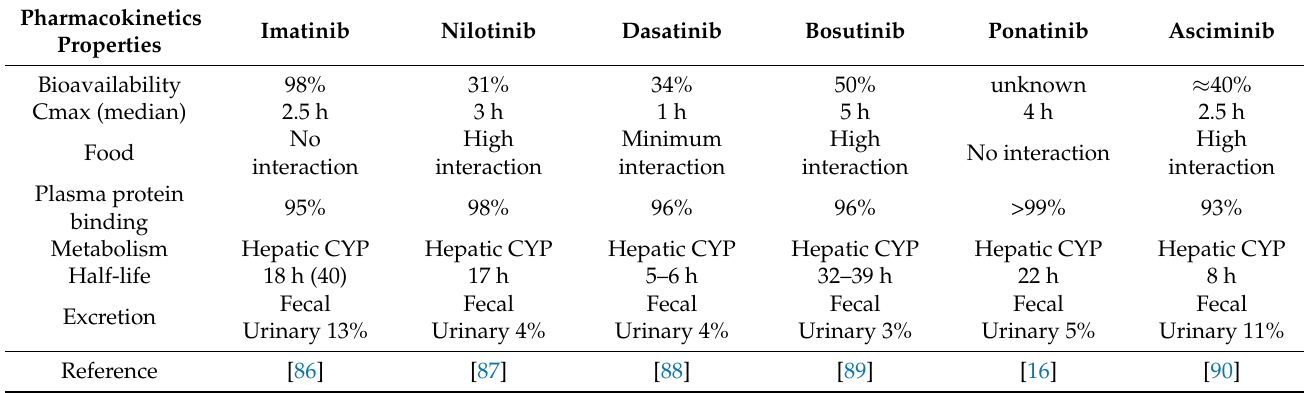
Table 5. ADME pharmacokinetics